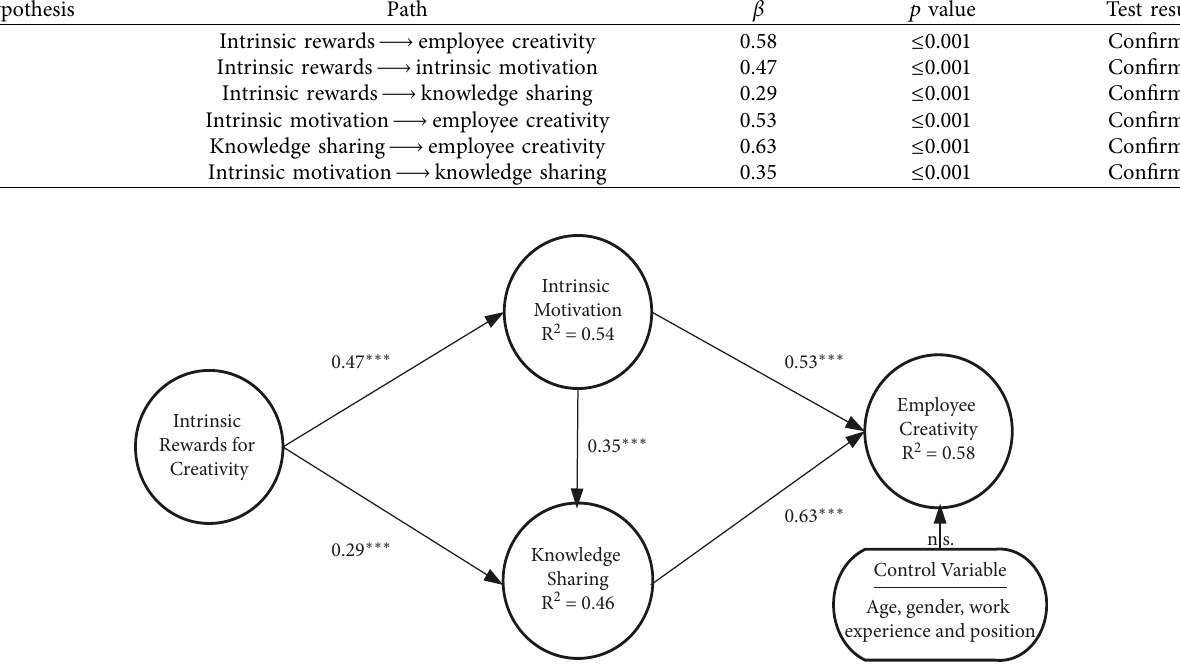
Figure 1: Results of the structural equation Table 5: The mediation analysis of intrinsic motivation and knowledge sharing.